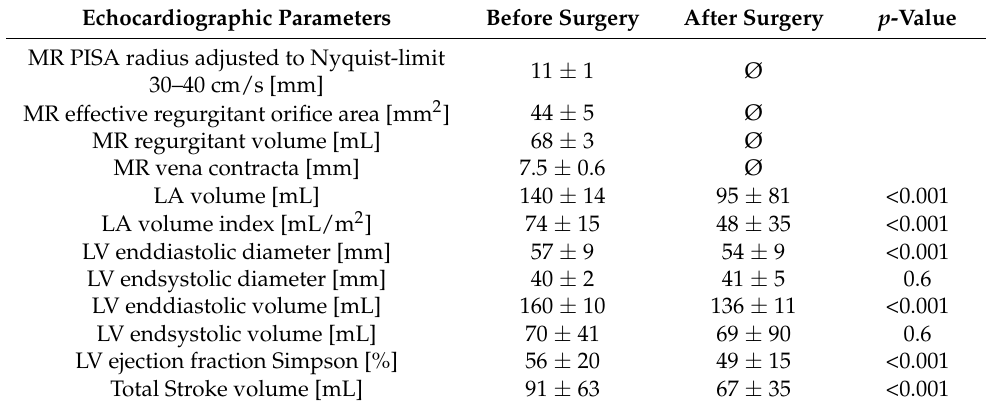
Table 2. Morphological and functional changes in the left ventricle 3 months after mitral valve